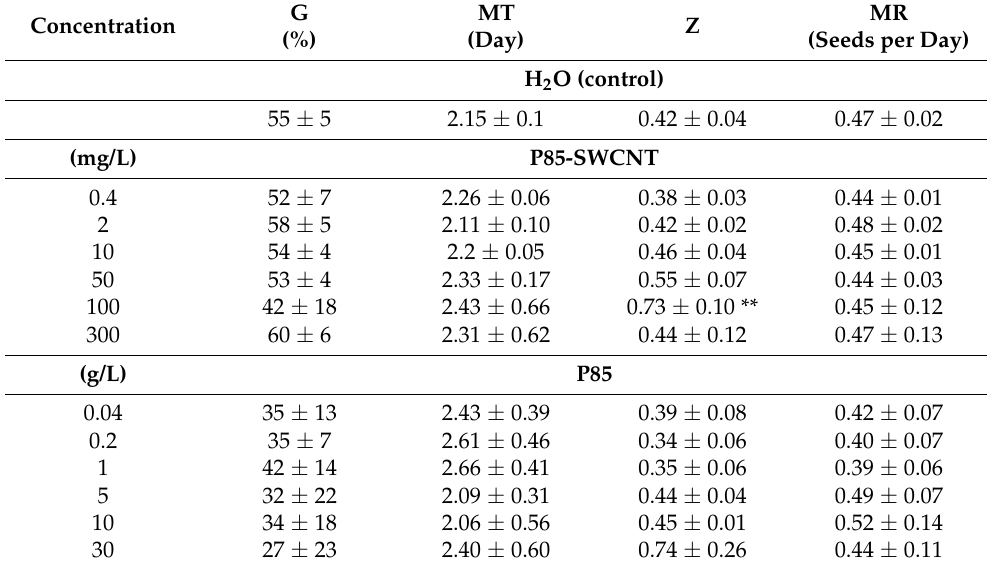
Table 2. Germination of hydro-, P85-SWCNT, and P85-primed pea seeds for a period of 4 days. Germination parameters (germinability (G, %), mean germination time (MT, day), mean germination rate (MR, seeds per day), and synchrony of the germination process (Z)) were estimated as in [31]. Mean ± SE. Statistically significant differences from the control sample at p < 0.05 (**) according to Student’s t -test are indicated.